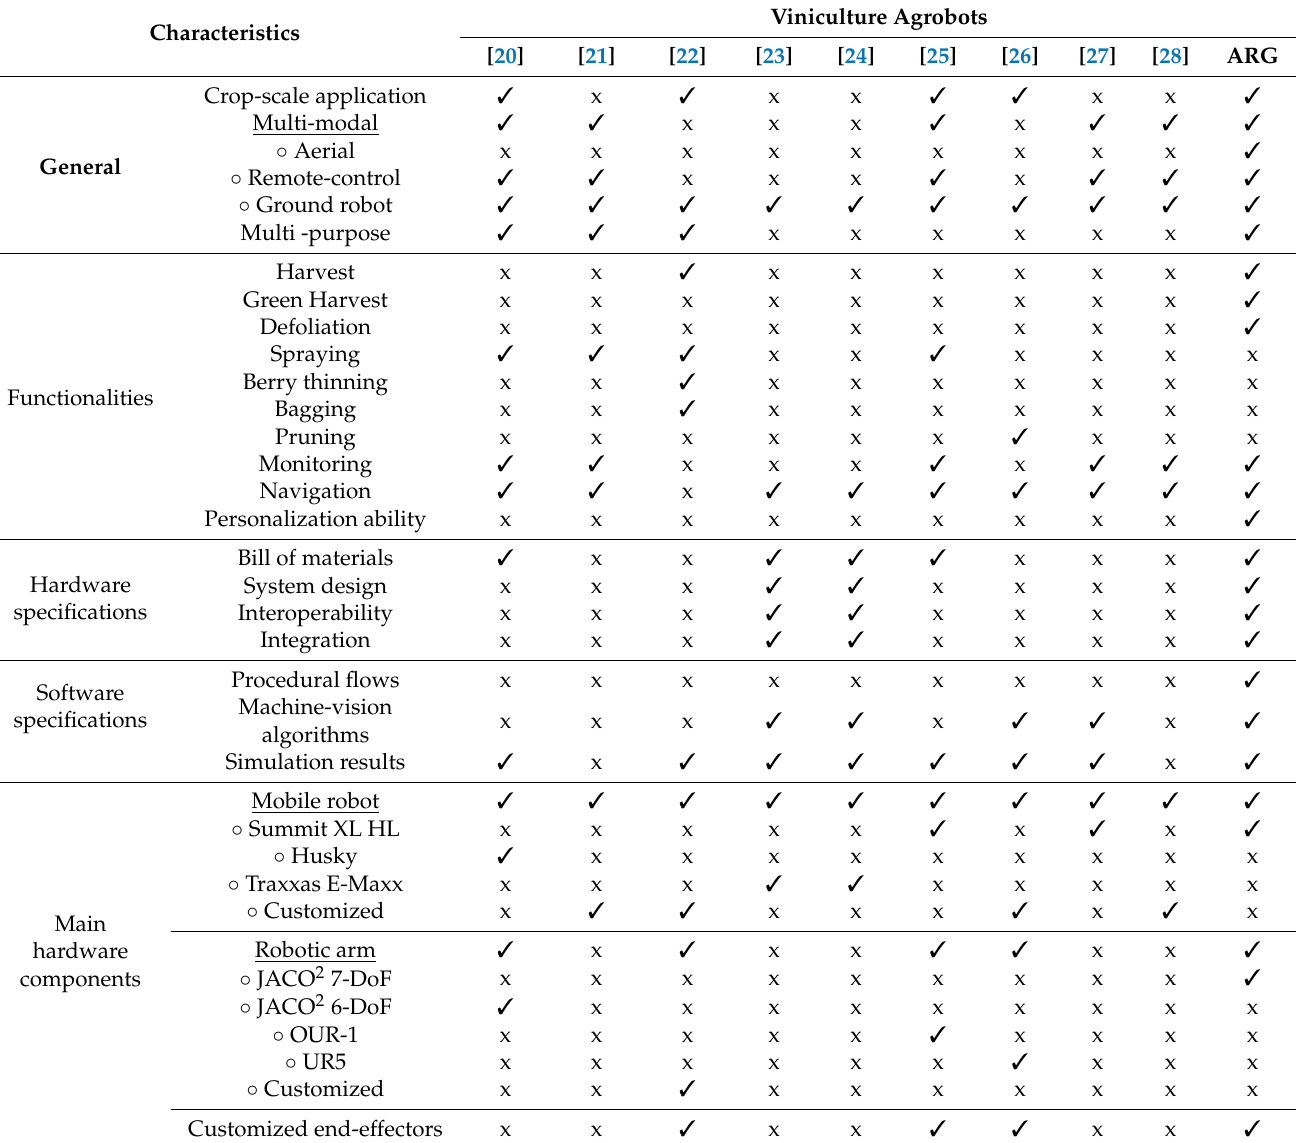
Table 1. Comparative table of characteristics of related work in viniculture agrobots.